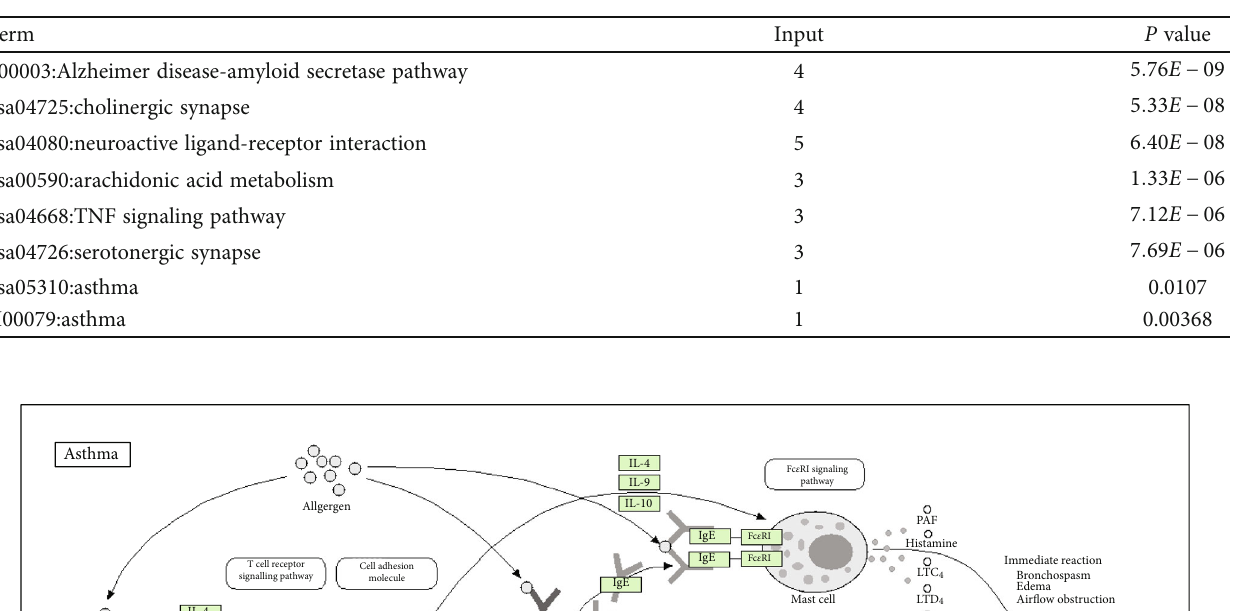
Table 5: KEGG pathway enrichment analysis of key 13 genes (part).